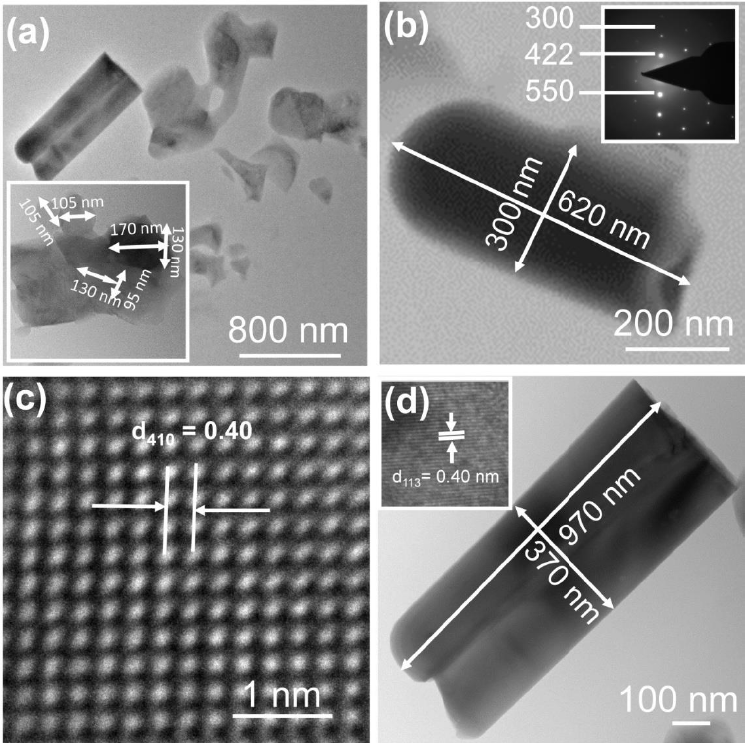
Figure 5. ( a ) Nanorod-like morphology of a 0.2 wt% Mn-doped Zn 2 SiO 4 . ( b ) Magnified view of na- norod-like morphology of individual rod with length 620 nm and width 300 nm. Inset shows the SAED result. ( c ) The HR-TEM image of nanorod. ( d ) HRTEM image of nanoflake-like morphology of individual rod of length 970 nm and width 370 nm. Inset shows the lattice fringe of nanorods corresponding to 113 plane.